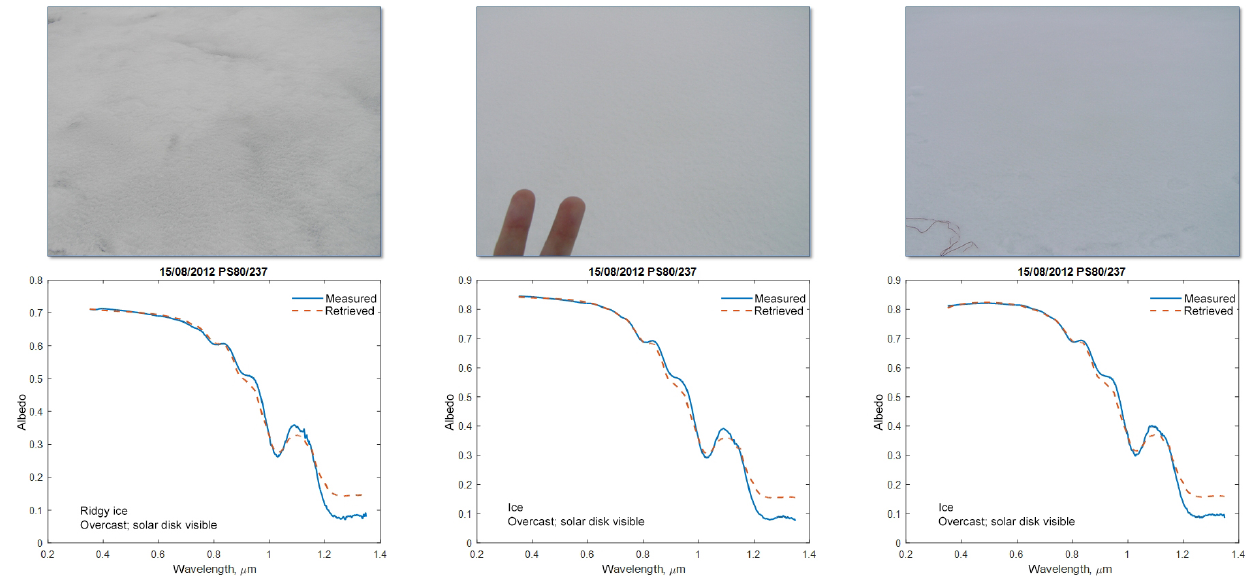
Figure 9. Typical white ice in Arctic summer. The surface is slightly wet; the grains are larger than those in dry white ice; the scattering layer is 12–18cm thick. The average air temperature is − 1.1 ◦